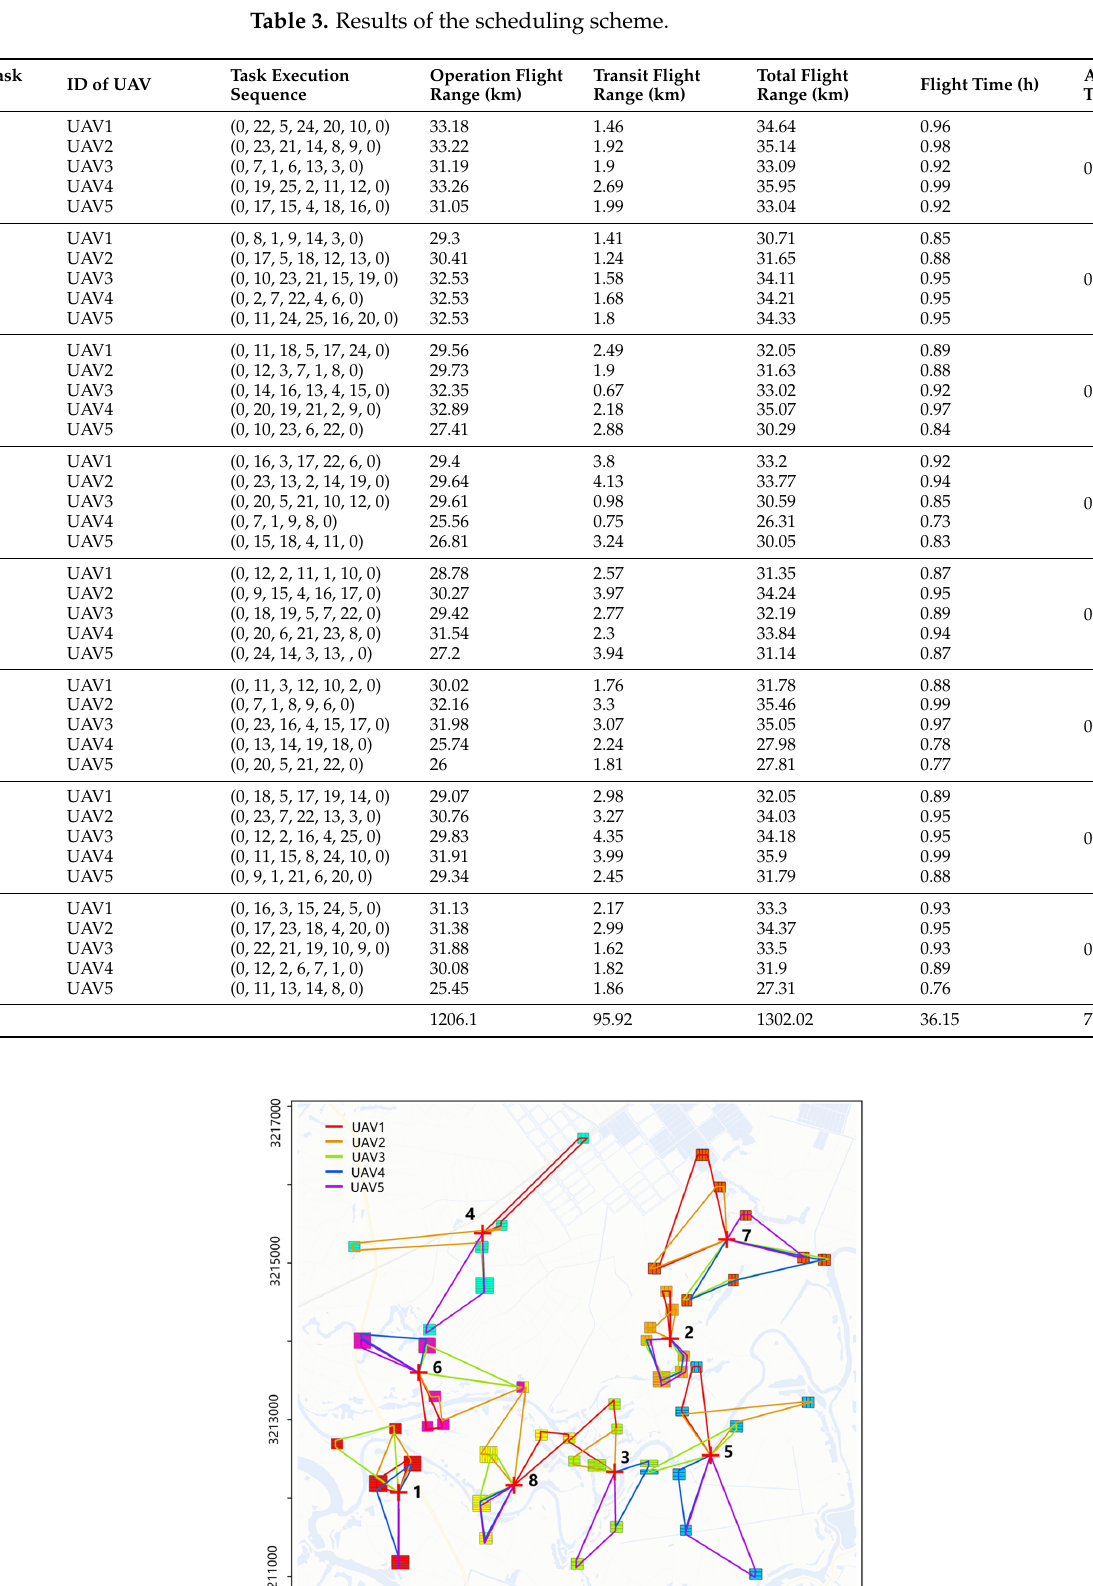
Figure 7. Flight trajectories of the UAV swarm.